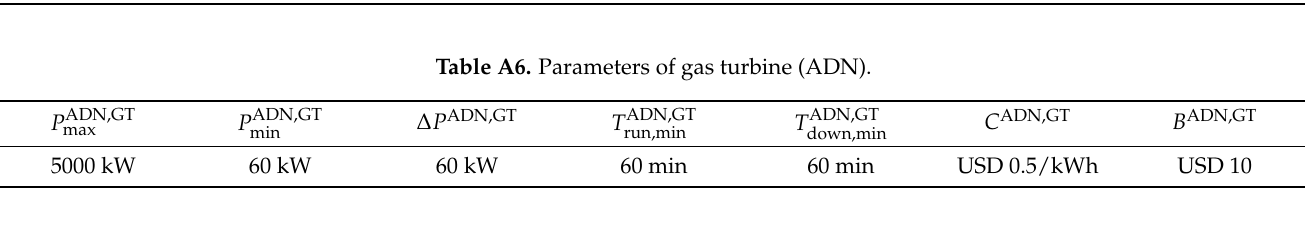
Table A7. Parameters of flexible load (ADN, in 96 intervals of 24h).